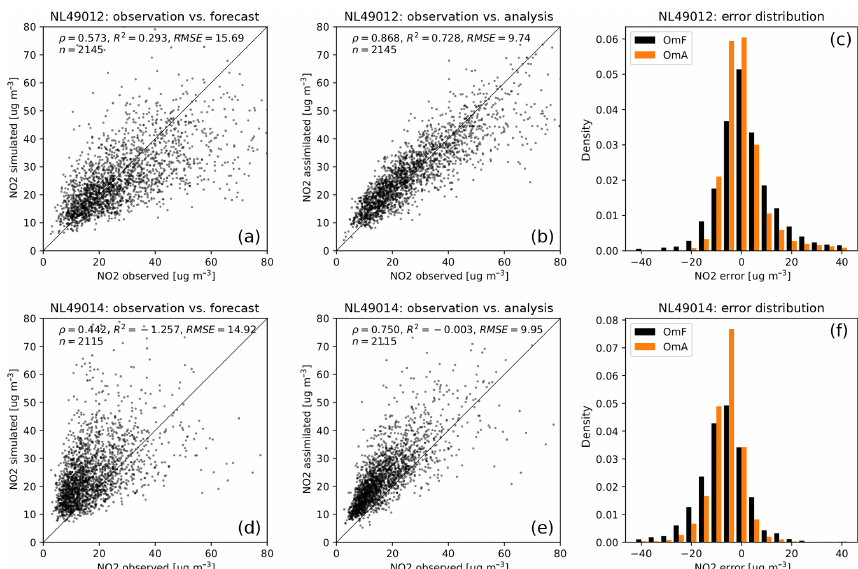
Figure 8. Validation of hourly time series for the period 1 June to 31 August 2016, for a well-performing street location (above) and a less performing urban-background location (below). Statistics of the n data pairs are given in correlation ( ρ ), coefficient of determination ( R 2 ), and RMSE. The right-hand panels compare the error distributions: the observation minus forecast (OmF) against the observation minus analysis